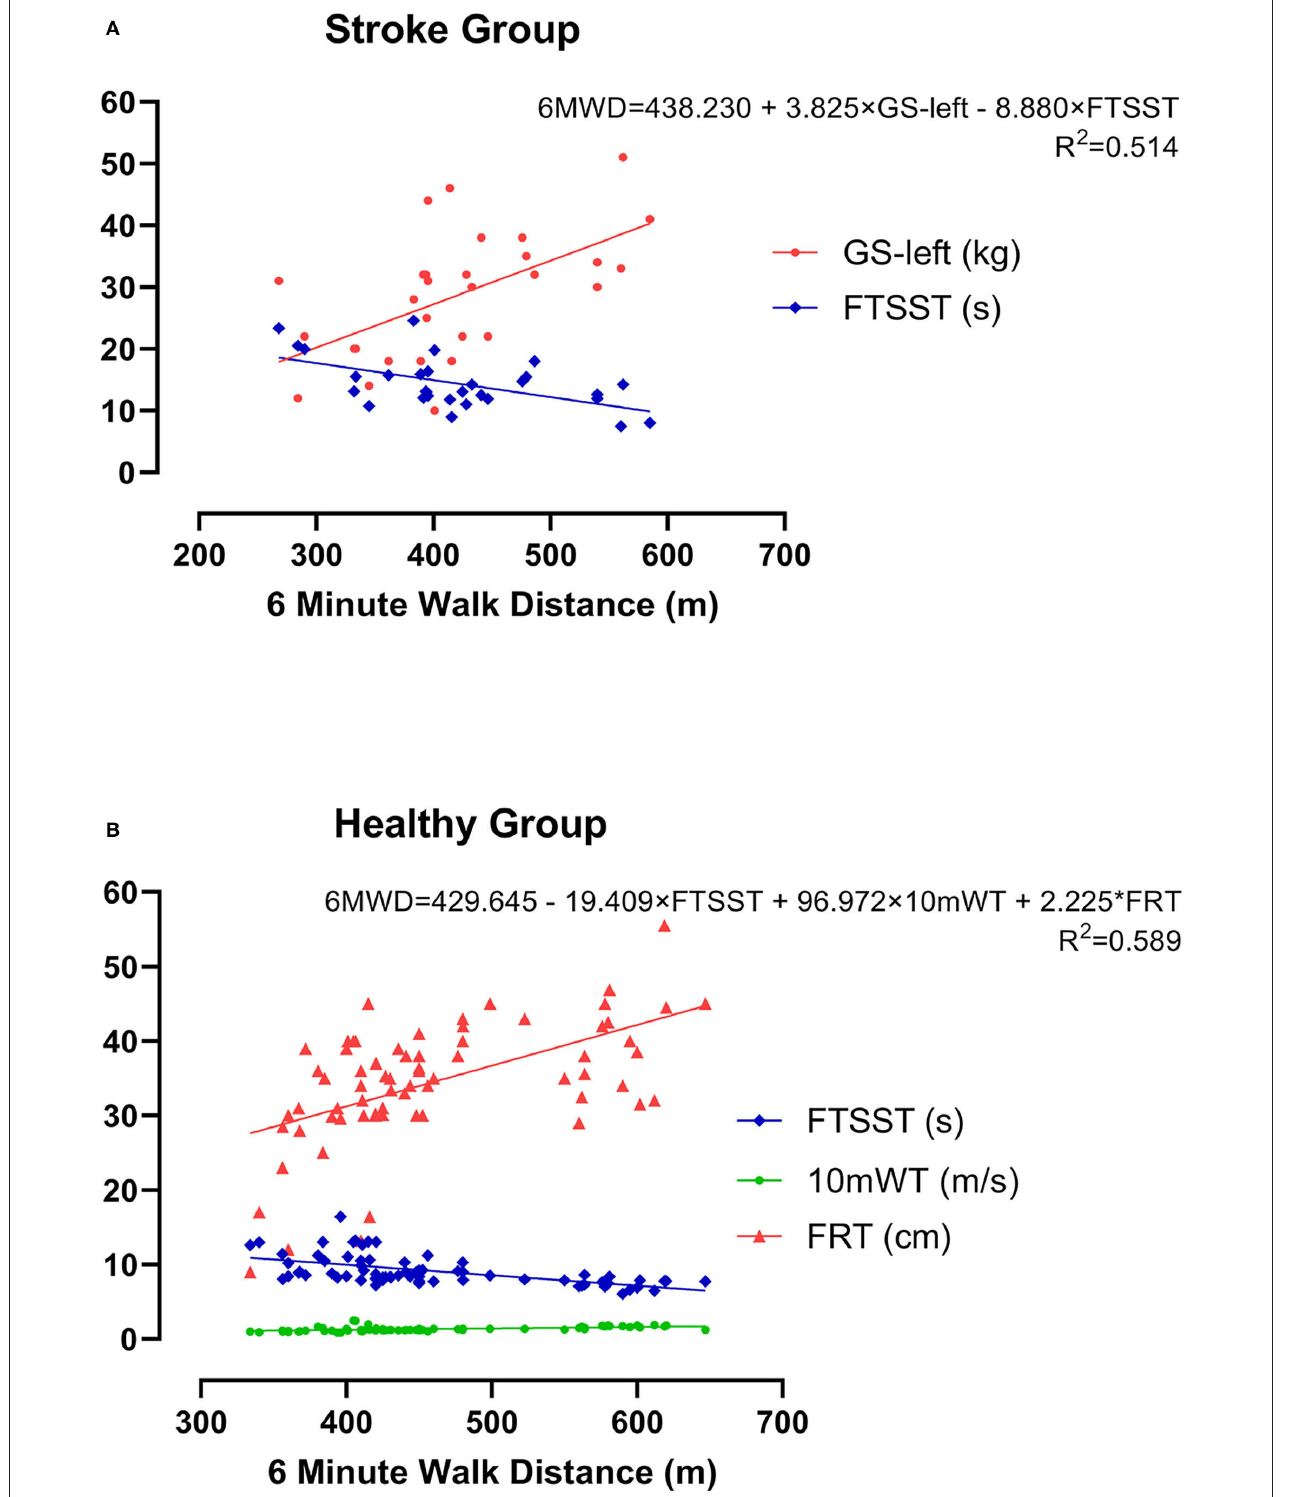
FIGURE 4 | The optimum model for estimating CRF as measured by 6MWD using multiple linear regression analysis in both groups. (A) Mild acute ischemic stroke group and (B) healthy control group.